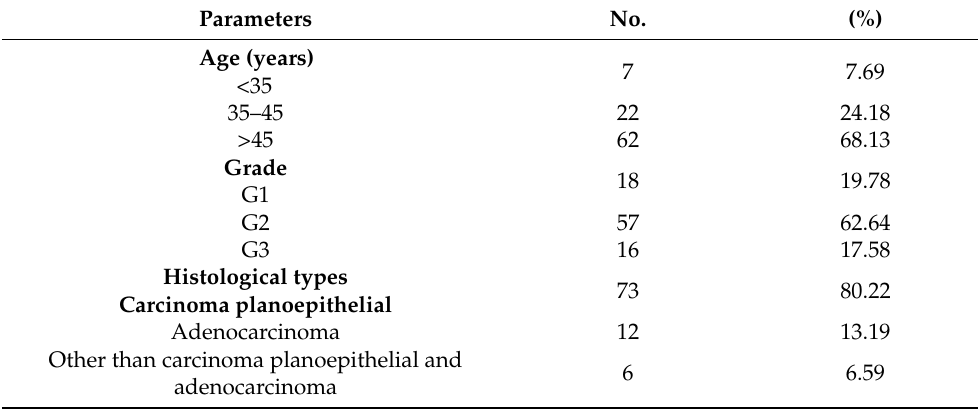
Table 1. Characterization of the study group and histological types of the cervical cancer samples.